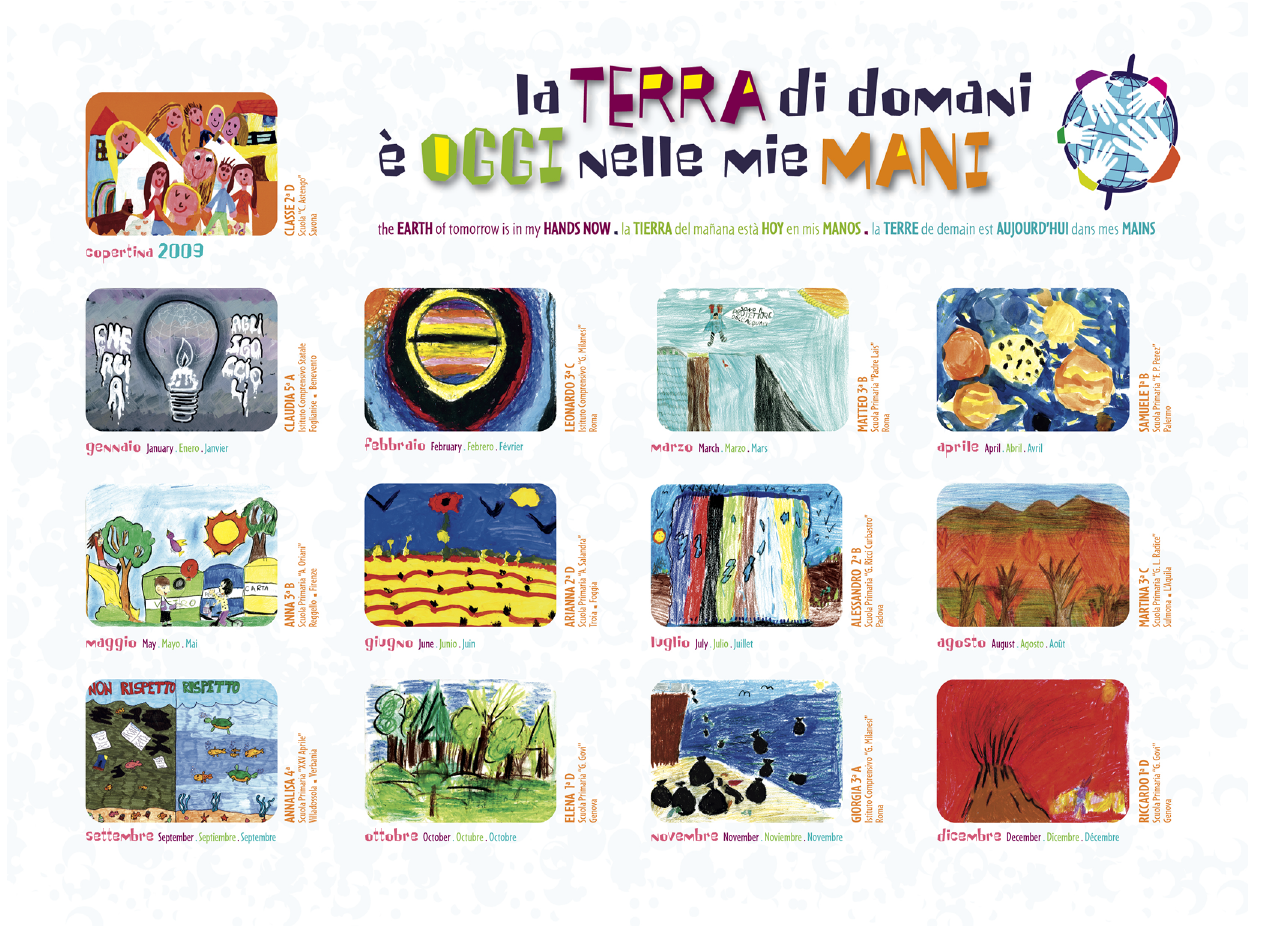
Figure 3. The back cover of the 2009 calendar dedicated to the Earth and to the present responsibility to protect the environment (edited by INGV Laboratorio Didattica e Divulgazione Scientifica and INGV Laboratorio Grafica e